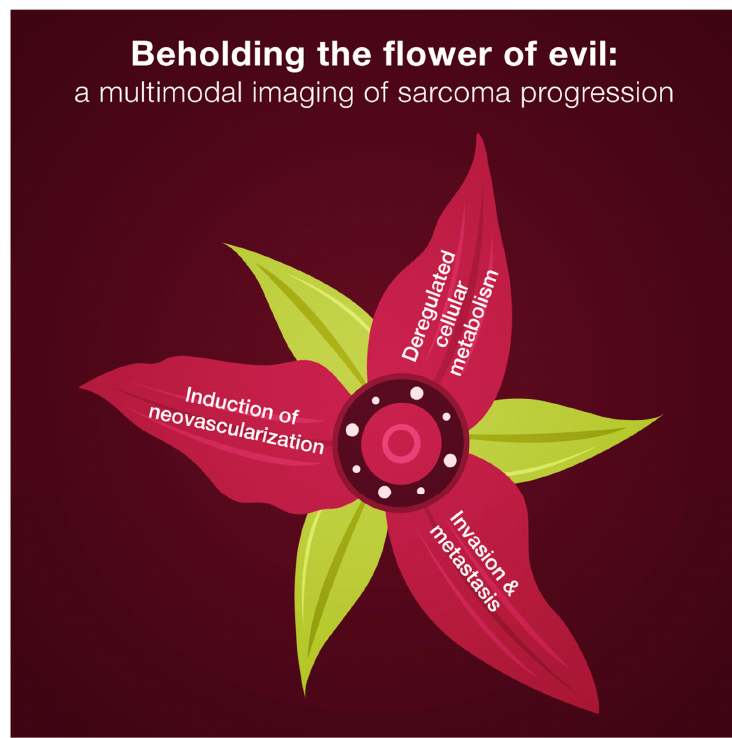
Figure 2. X-ray computed tomography reveals three cancer hallmarks of sarcoma progression.